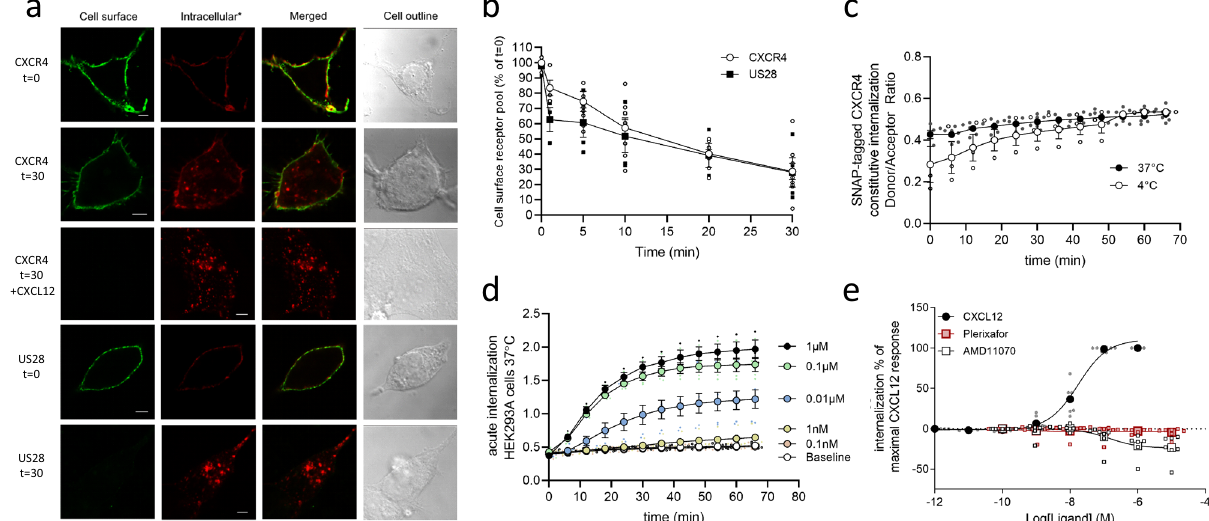
Fig. 2 Internalization of CXCR4 is differentially affected by CXCL12, plerixafor, and AMD11070. a Antibody feeding experiment with FLAG-tagged CXCR4 and US28 in HEK293 cells. The cells were either immediately fi xed ( t = 0) or incubated at 37 °C for 30 min to induce internalization ( t = 30) and then fi xed. CXCL12 was added at 1 μ M. Cell surface receptors are labeled with Alexa Fluor 488-conjugated secondary antibody (green, left column), while internalized receptors were labeled with Alexa Flour 568-conjugated secondary antibody (red, second column from left). Nomarski images are included to illustrate the cell outline (right column). Scale bar, 5 μ m. Images show representative cells from three independent experiments. b Acute time-course internalization ELISA. HEK293 cells were transiently transfected with FLAG-tagged CXCR4 (white circle) or US28 (black square). For each receptor, the value at a given time point is corrected for background, normalized to the value at t = 0, and presented in percent with mean ± SEM shown. The experiment was performed at least four times in quadruples. c SNAP-tag CXCR4 constitutive internalization. Internalization was determined after preincubation with Tag-lite SNAP-Lumi4-Tb (donor) for 1 h at 4 °C (white circle) or 37 °C (black circle) and shown with mean ± SEM from at least four independent experiments performed in triplicates. d SNAP-tag CXCR4 agonist CXCL12 induced internalization in HEK293A cells. Cells were stimulated with increasing concentration of CXCL12; 0 nM (white circle), 0.1 nM (orange circle), 1 nM (yellow circle), 0.01 µ M (blue circle), 0.1 µ M (green circle) or 1 µ M (black circle). Internalization was determined upon CXCL12 addition after 1-hour preincubation with Tag-lite SNAP-lumi4-Tb at 37 °C. Data are shown with mean ± SEM of triplicates from at least three independent experiments. e SNAP-tagged CXCR4 receptor internalization after stimulation with CXCL12 (black circle), plerixafor (red square), and AMD11070 (white square). The data were normalized to maximal internalization levels by CXCL12 for CXCR4 and presented with mean ± SEM of triplicates from at least six independent